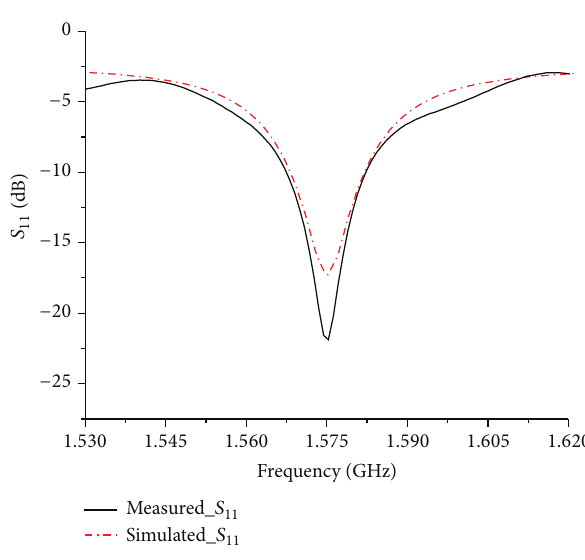
Figure 9: Simulated and measured 𝑆 11